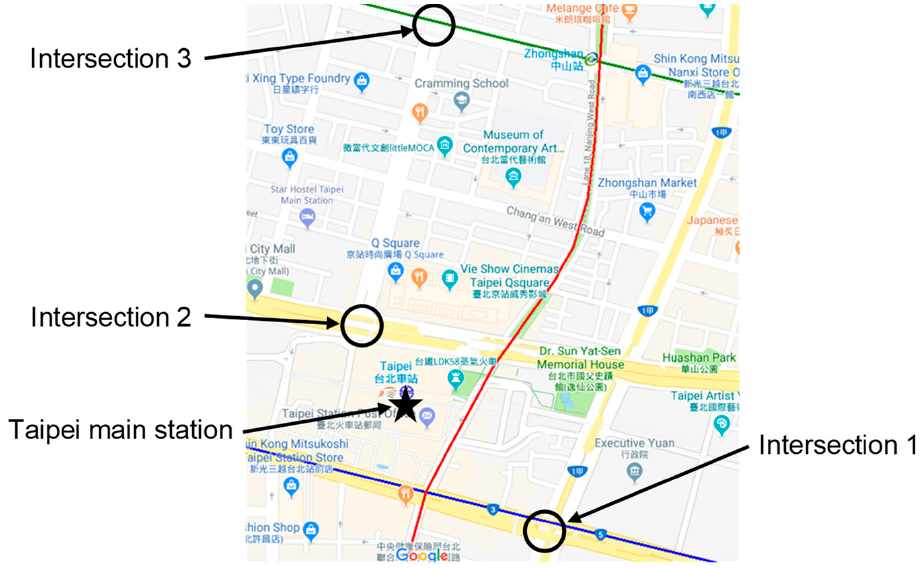
Figure 1. Map of the surveyed sites.